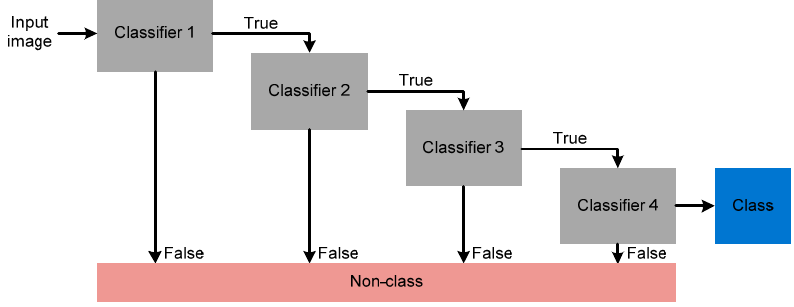
Figure 5. Concept for the cascading structure of the face-detection module in the proposed algorithm.